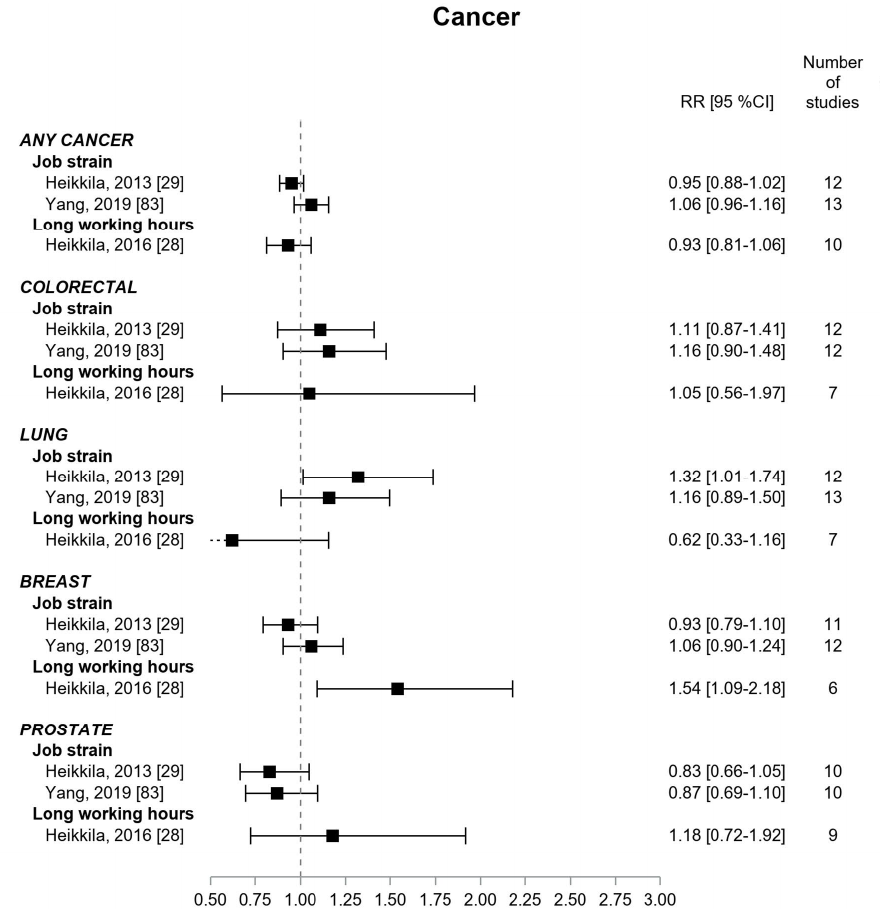
Figure 11 . Pooled estimates for the associations between psychosocial work exposures and cancer. * IPD-Work Consortium studies without systematic literature review.